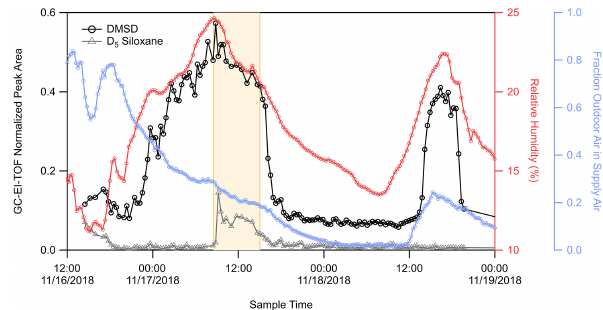
Figure 4. Time series of DMSD (black trace) and D 5 siloxane (grey trace) detected by GC-EI-TOF (normalized counts, ncts), weight room relative humidity (pink trace), and the fraction of outside air in the room supply air (blue trace). The area highlighted in yellow represents the time during which pre-game activities and a football game were occurring adjacent to the athletic